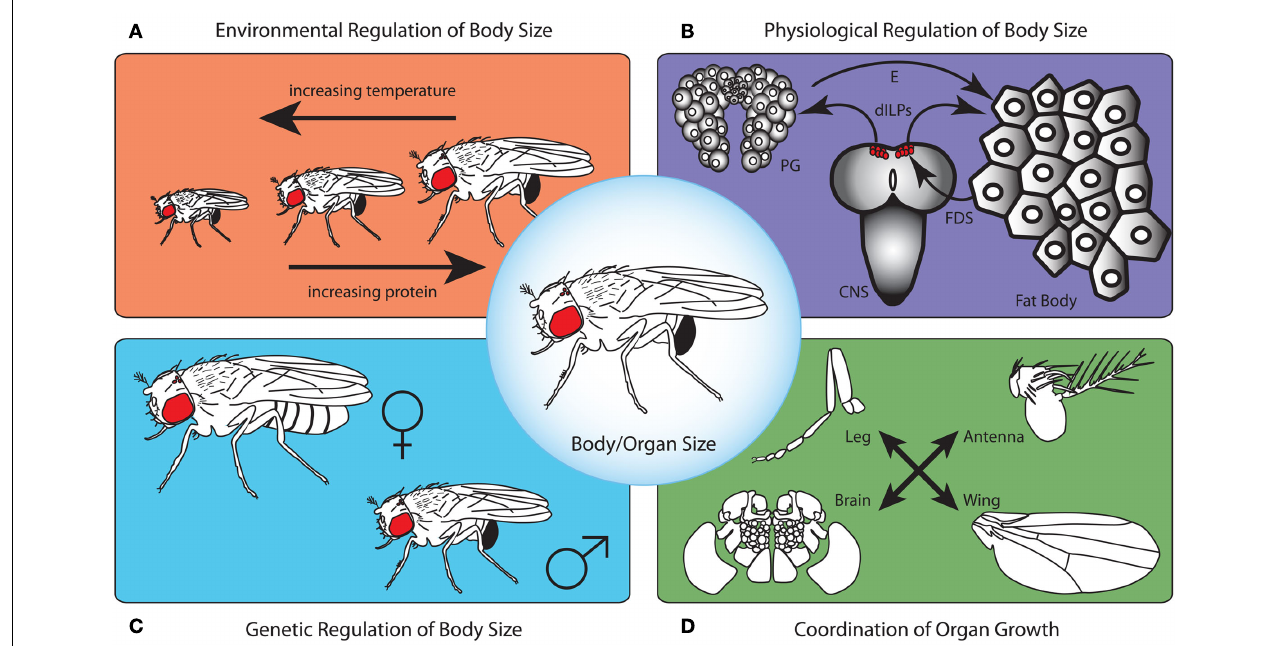
producing neurosecretory cells to regulate the production of Drosophila insulin-like peptides (dILPs). dILPs, in turn regulate growth rate and the production of the steroid molting hormone ecdysone (E) by the prothoracic gland cells thereby determining the duration of the growth period. For any given environmental condition, the genetic background contributes to overall body size (C) . For example, independent of rearing conditions, males are typically smaller than females. Lastly, in addition to this physiological regulation of whole body size, the size of individual organs is controlled by mechanisms that regulate organ-autonomous growth and those that ensure organs grow in proportion to one another (D)